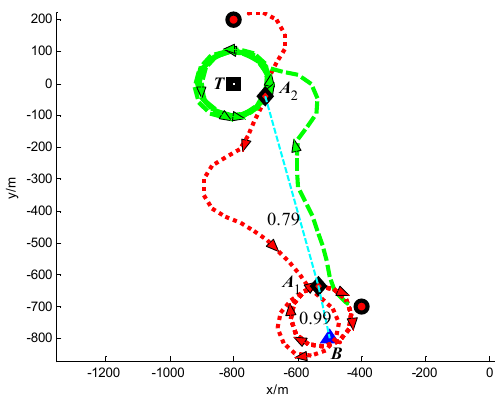
Figure 24. Trajectories of UAVs at t = 100 s (Group B in Scenario 2).